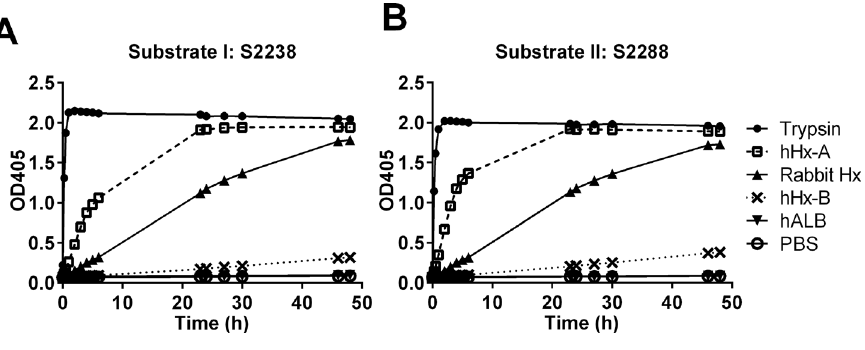
Figure 1. Protease activity of purified Hxs. Enzymatic activity of different purified Hxs (two human and one rabbit) was tested at the same molar concentration (6.7 μ mol/L) using chromogenic substrate I: S2238 and II: S2288 that are sensitive to thrombin and serine proteases respectively. Trypsin (0.4 μ mol/L) was used as positive control. The substrates were mixed with different Hxs or controls and incubated at 37°C for different times. The absor- bance at 405 nm was measured by spectrophotometry. The results represent mean ± SE and are representative of three independent